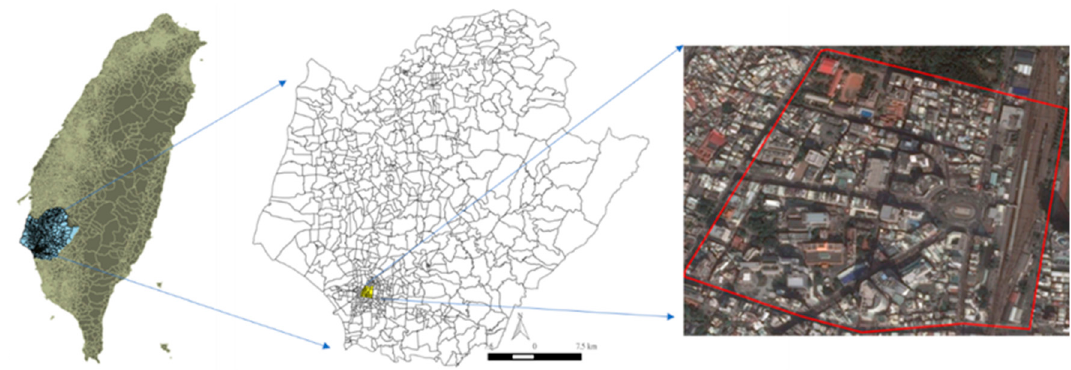
Figure 1. Location of the study area. The blue mark represents the province of Tainan city, the red frame shows the area of interest.